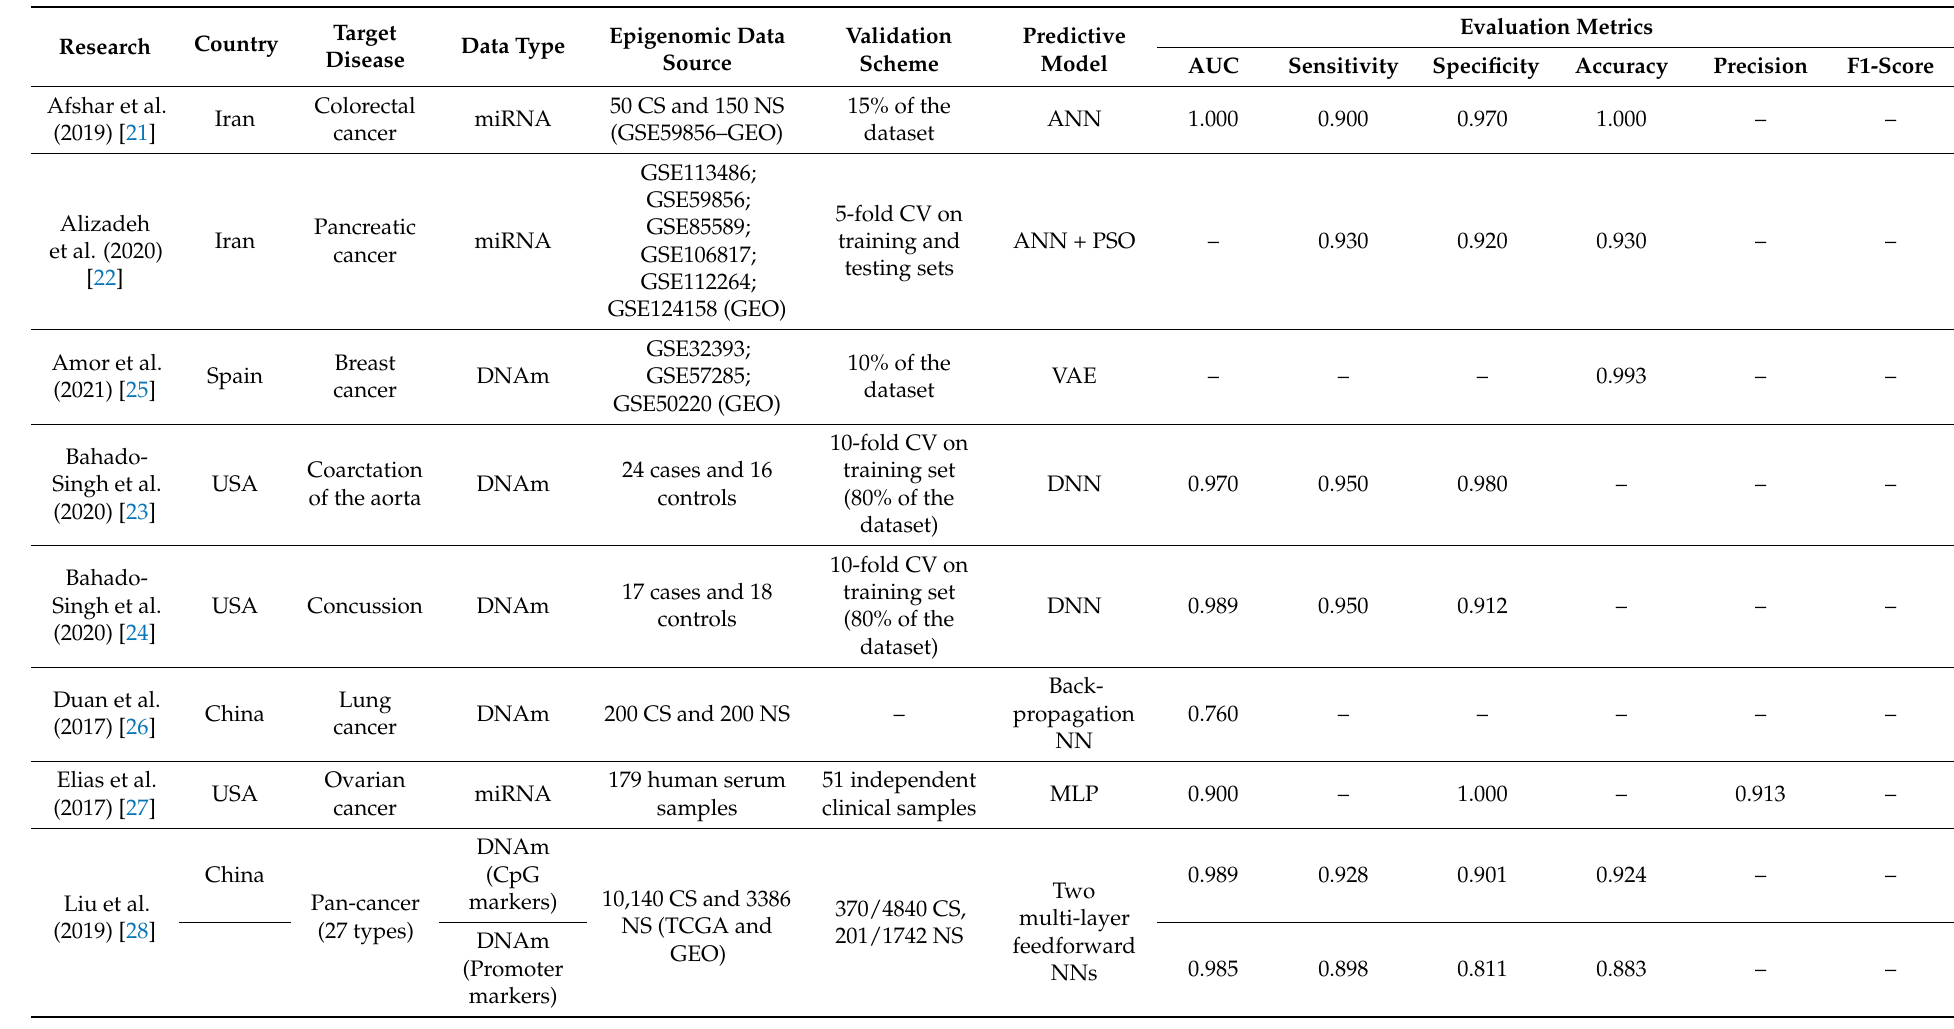
Table 2. Comparison of DL models for disease detection using epigenomic